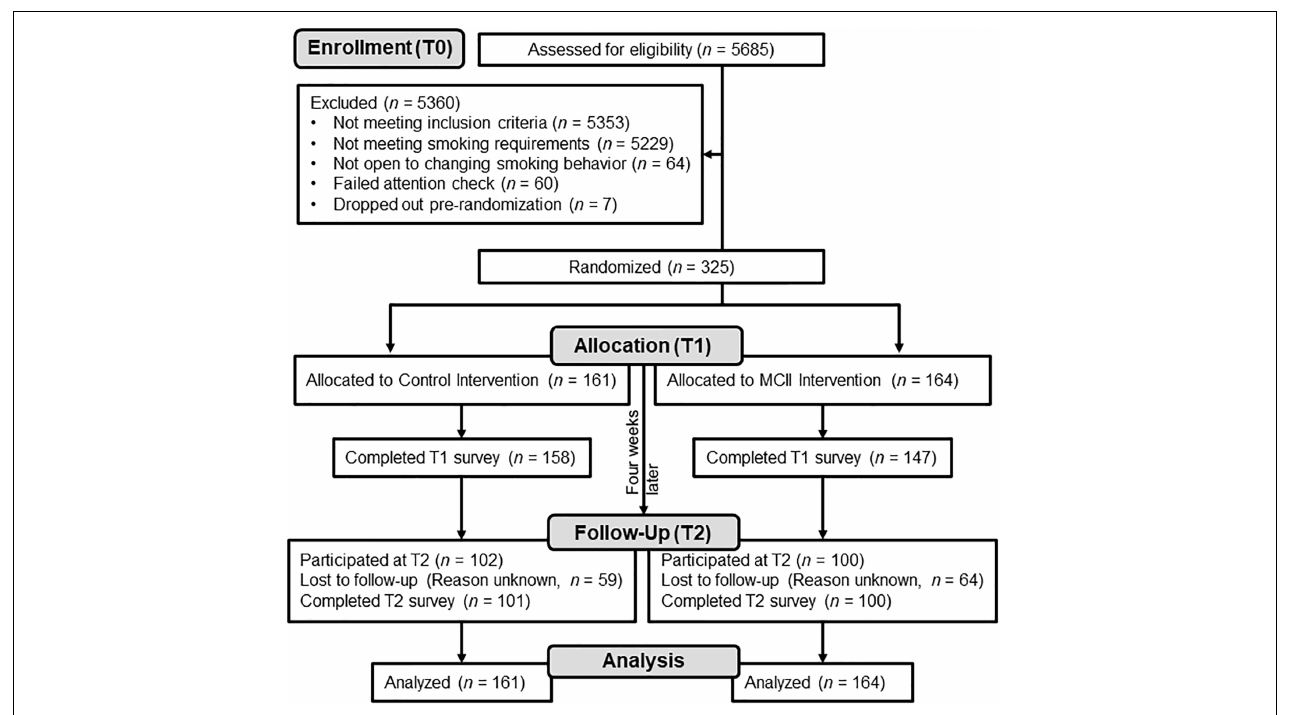
FIGURE 1 | Participant flow diagram. MCII, mental contrasting with implementation